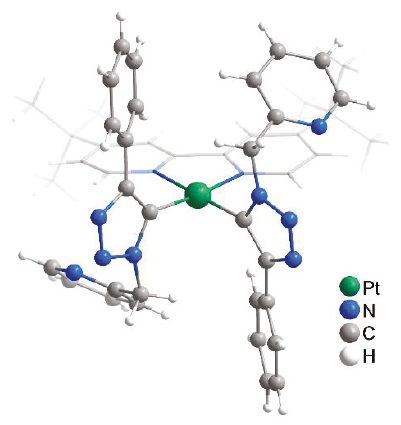
Figure 1. Molecular structure of Pt(dtbpy) C complex.